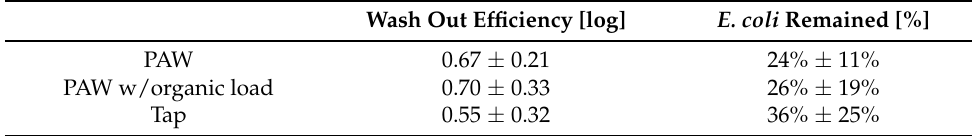
Table 1. The effectiveness of PAW in bacterial